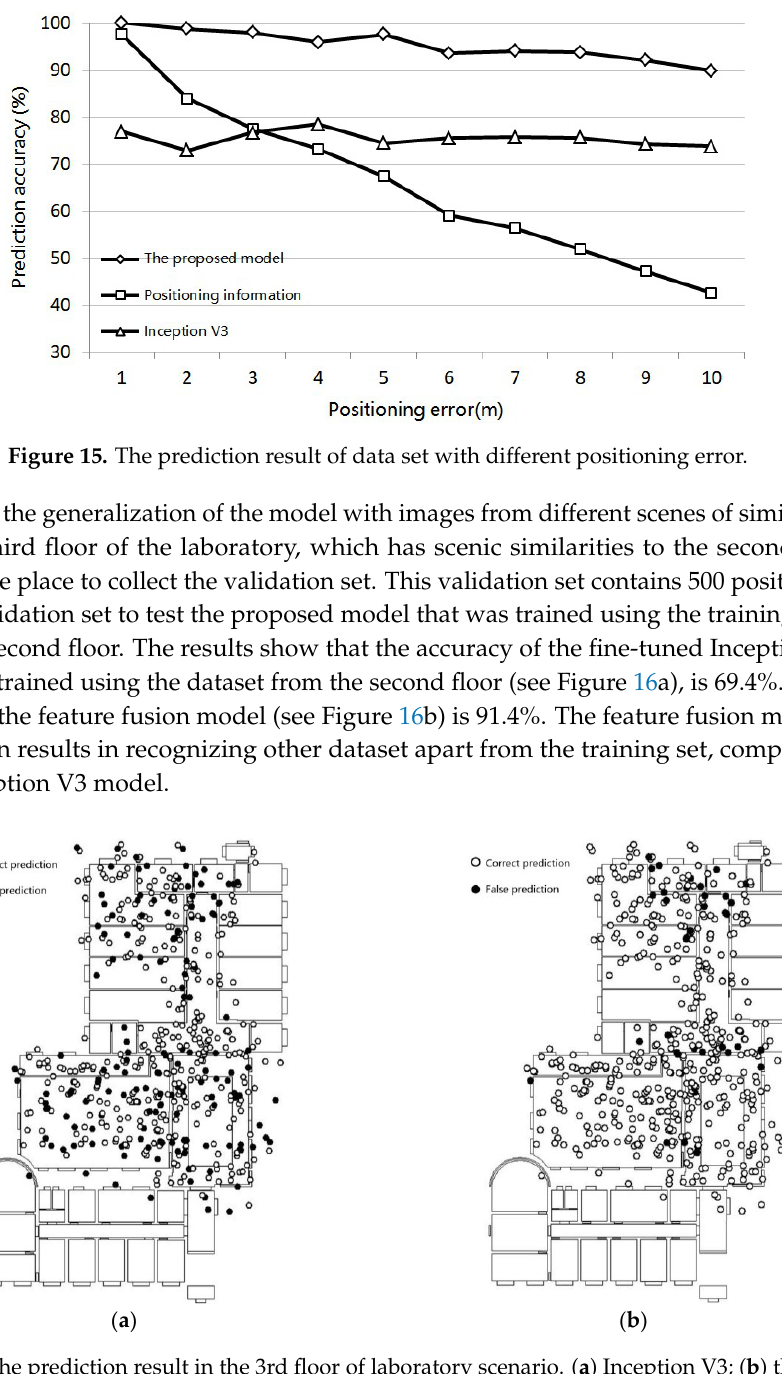
Figure 16. The prediction result in the 3rd floor of laboratory scenario. ( a ) Inception V3; ( b ) the feature fusion model.